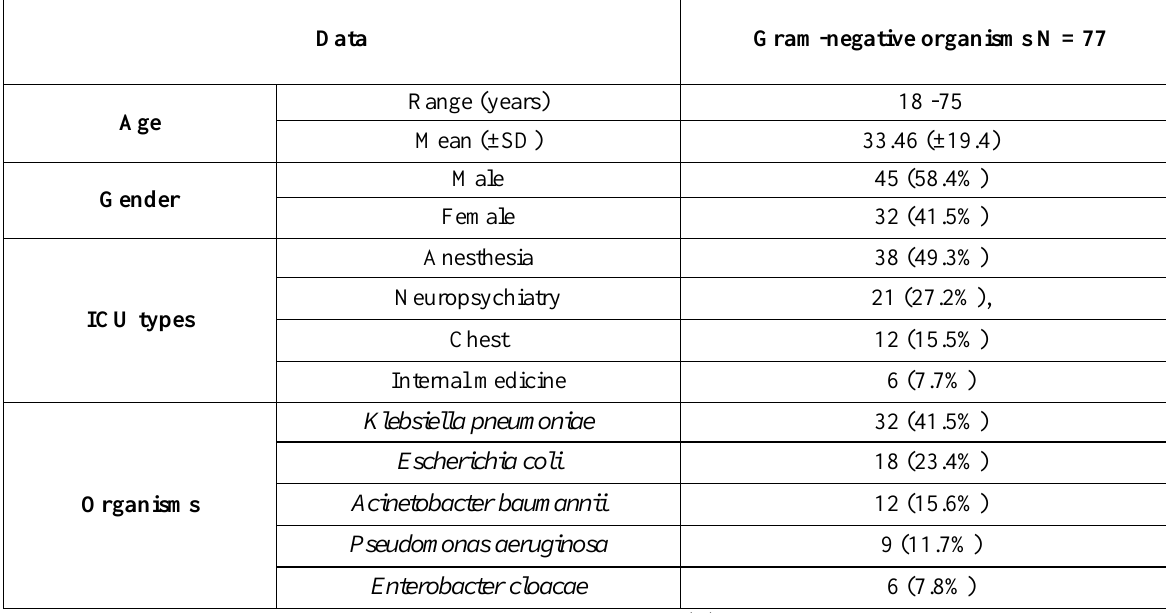
Table 3. Descriptive data of patients infected by isolated Gram-negative organisms.